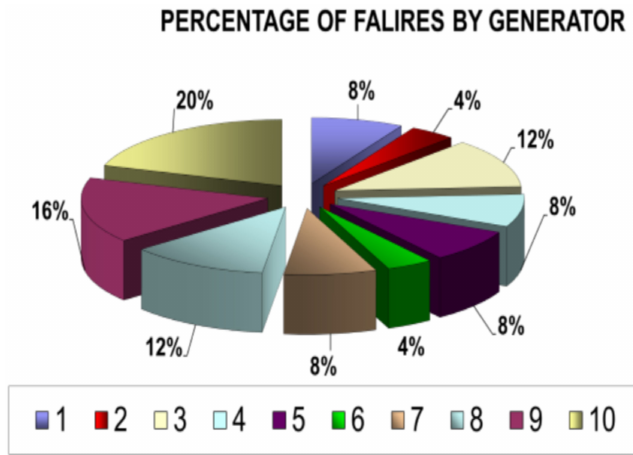
Figure 17. Percentage of failures per generator